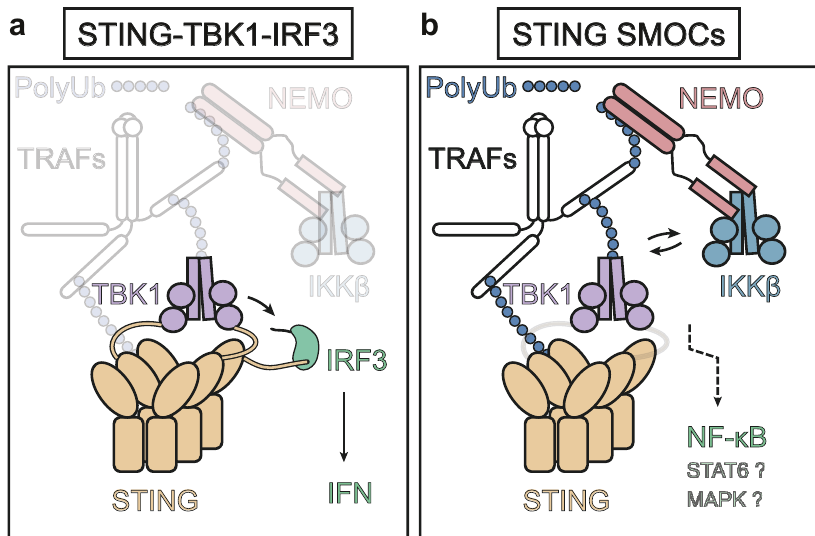
Fig. 3 A proposed STING SMOCs model reconciling the TBK1-IRF3 and NF- κ B activation. a STING – TBK1 – IRF3 complex activates IRF3 and induces IFN production in a STING C-terminal tail-dependent way. b Activated STING polymerizes and recruits essential adaptors like TRAFs, NEMO, and IKK β , beyond the STING – TBK1 – IRF3 complex. Ubiquitination chains are covalently linked to various components of these SMOCs and stabilize the complex. A positive feedback loop exits between TBK1 and IKK β to assure full activation of NF- κ B, which may not depend on the STING C-terminal tail but require TBK1. Enigmatic mechanisms of STAT6 and MAPKs activation could also originate in this complex. cGAMP cyclic GMP – AMP, IFN interferon, IKK β inhibitor of NF- κ B kinase beta, IRF3 interferon regulatory factor 3, NEMO NF- κ B essential modi fi er, PolyUb polyubiquitin chain, STING stimulator of interferon genes, SMOCs supramolecular organizing centres, TBK1 TANK-binding kinase 1, TRAFs tumor necrosis factor receptor-associated